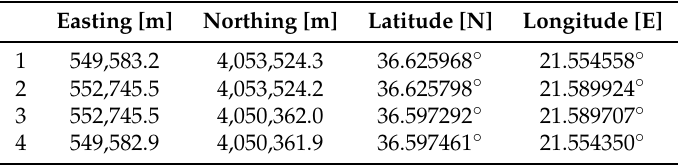
Table 4. The coordinates of the points delimiting the boundaries of the obligatory survey box (10 km 2 ) to be mapped by the teams participating in the Final Round of Shell Ocean Discovery XPRIZE (WGS84 Spheroid, WGS84 Datum, UTM Projection coordinates refer to Zone 34 North). Easting [m]